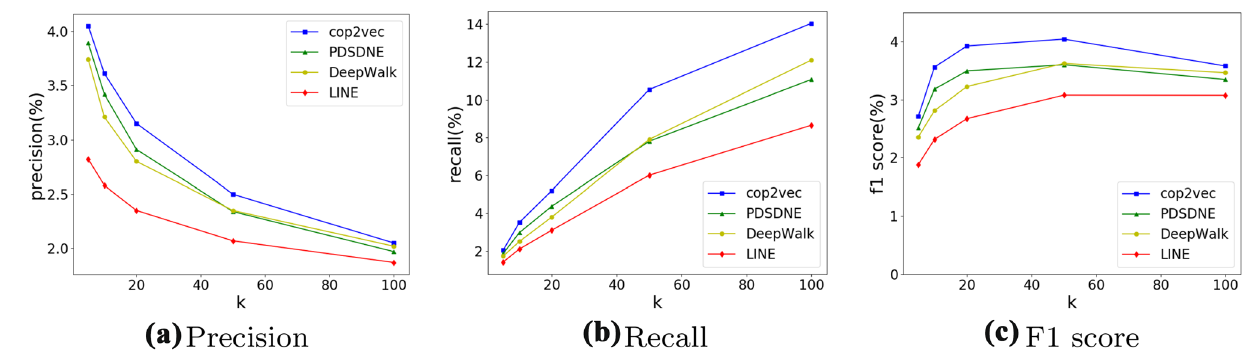
Fig. 8 The performance evaluation of Top- k purchaser